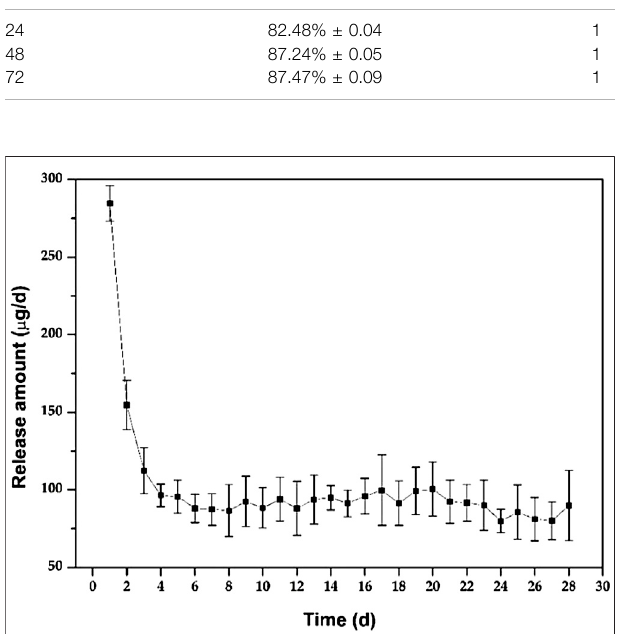
FIGURE3| Invitro releaseoftheCipro fl oxacin-loadedPTMCimplantsin PBS